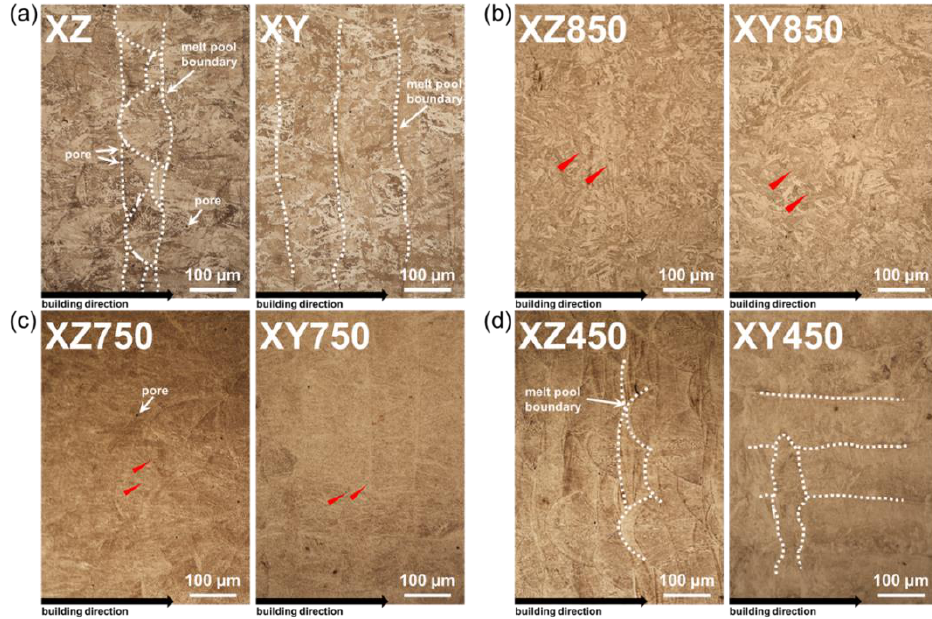
Figure 2. OM images of laser-powder-bed-fused MS: ( a ) as-built, ( b ) 850 °C heat treated, ( c ) 750 °C heat treated, and ( d ) 450 °C heat treated.